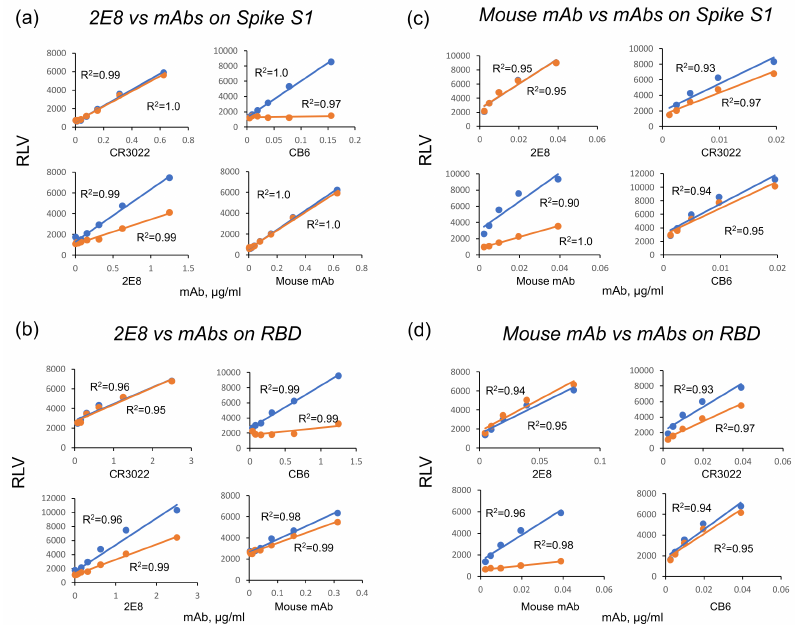
Figure 2. Epitope binning the 2E8 on the SARS-CoV-2 S1 and RBD. We performed competition binding assays to test 2E8 binding in the presence of the CR3022, CB6, and the murine anti-S1 mAb. L-type spike ( a , c ) or RBD ( b , d ) was captured on the plate and binding of biotinylated 2E8, or the anti-spike murine mAb was tested in the presence of non-biotinylated competitor mAbs. Blue, no competitor; orange, competitor